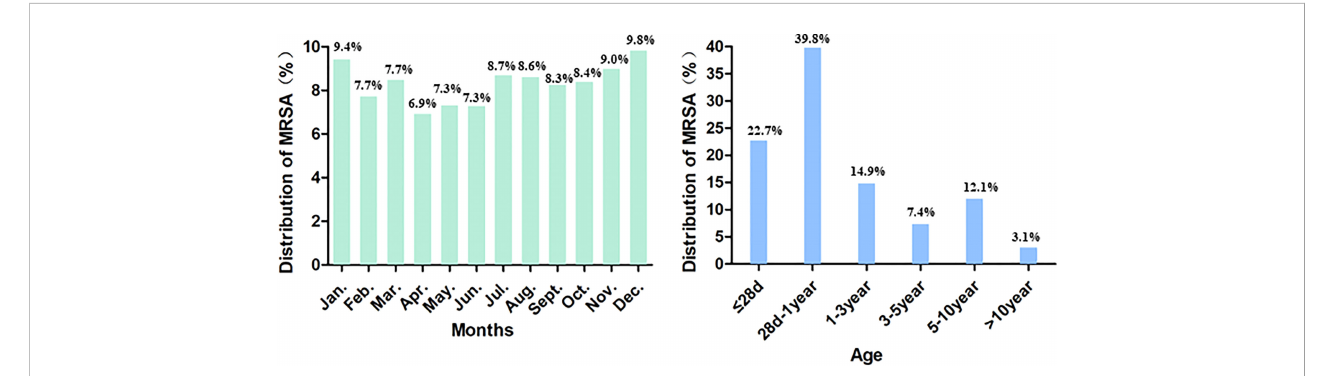
FIGURE 1 Demographics of patients with MRSA